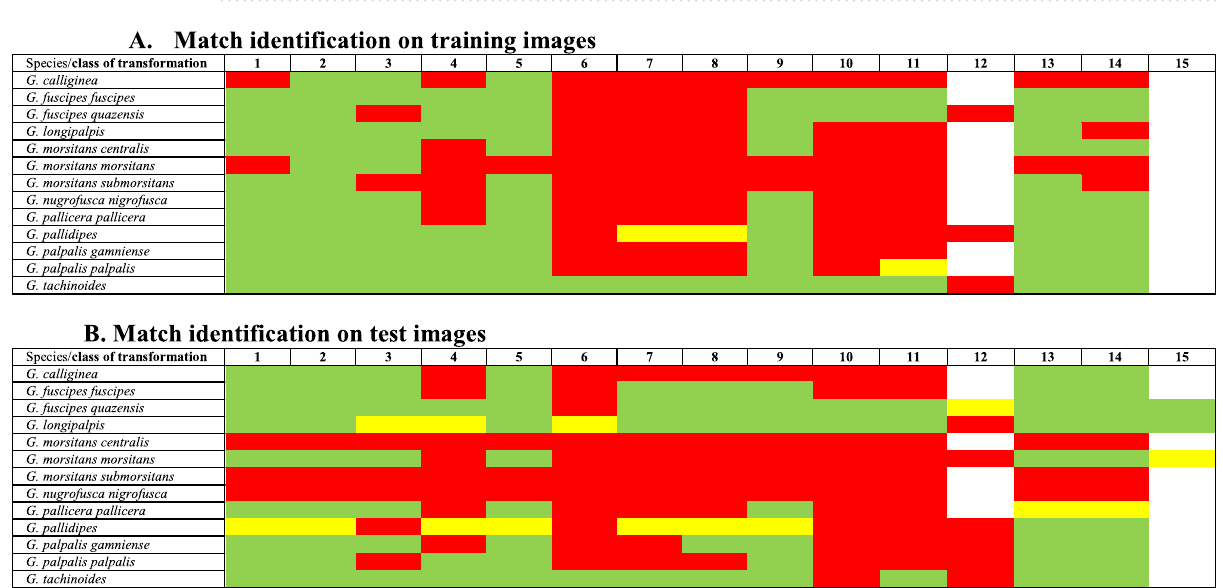
Table 4. Identification accuracy on manually and computed transformed WIPs pictures, modified pictures taken in the training dataset ( A ) and the test dataset ( B ) Legends: Green 100% match of identification, yellow identification below 100%, red no match of identification, white no samples submitted for identification. Transformation process using computer application (1 no transformation, 2 gaussian blurs, 3 lens blur, 4 video distortion, 5 scatter, 6 throws, 7 scrambling RVB, 8 scrambling CIE) or manual transformation (9 trailing edge cropping, 10 wings cropping from vein V, 11 wings cropping to the vein VI, 12 original picture without color saturation, contrast and resizing transformations, 13 horizontal flips, 14 vertical flips, 15 resized original